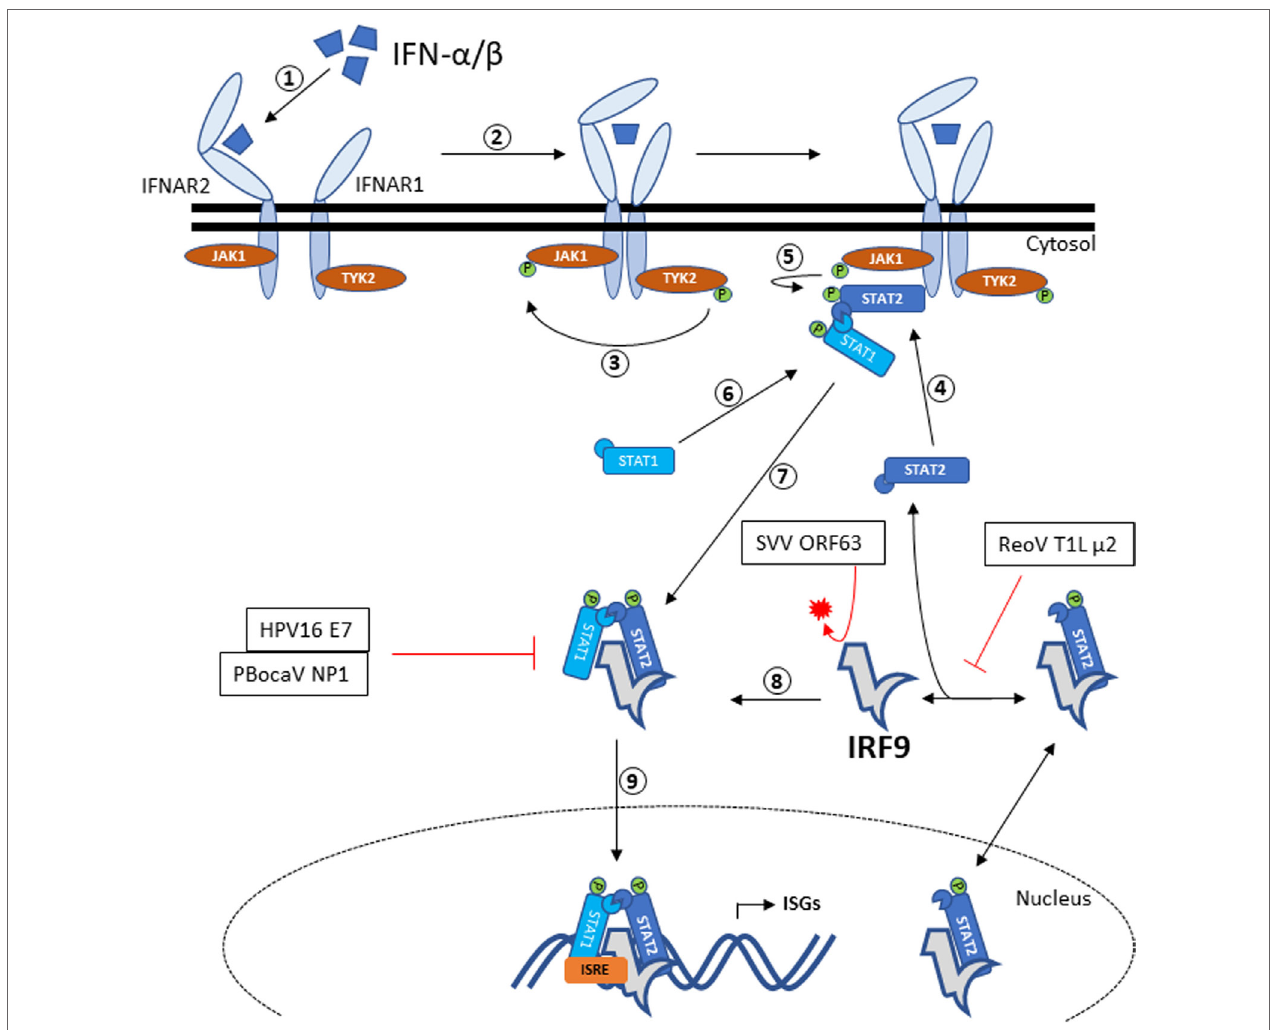
FiGURe 1 | IRF9 signaling via the JAK–STAT pathway and antagonism by viral proteins. Recognition of IFN- α / β by IFNAR2 will trigger heterodimerization to IFNAR1, resulting in autophosphorylation of TYK2. Activated TYK2 then phosphorylates the adjacent JAK1. STAT2 recruited by activated IFNAR2 will be phosphorylated by JAK1, thus allowing docking of STAT1 that in turn gets phosphorylated. The phosphorylated STAT1–STAT2 heterodimer then dissociates from the IFNARs and forms the ISGF3 complex with IRF9. ISGF3 complex is then translocated into the nucleus and bind to the ISRE promoter sequence to initiate the transcription of ISGs. IRF9 has been shown to associate with STAT2 and shuttles between the cytoplasm and nucleus. Also annotated are the viral antagonisms directed toward IRF9. HPV16 E7, ReoV T1L μ 2, and PBocaV NP1 binds to IRF9 and therefore prevents the formation of ISGF3 complex. Meanwhile, SVV ORF63 directs the proteasomal degradation of IRF9. Abbreviations: HPV16 E7, human papillomavirus 16 E7; SVV ORF63, simian varicella virus ORF63; ReoV T1L μ 2, reovirus T1L μ 2; PBocaV NP1, porcine bocavirus NP1; IRF9, interferon regulatory factor 9; IFNAR, IFN alpha receptor; TYK2, tyrosine kinase 2; JAK-STAT, Janus kinase–signal transducer and activator of transcription; ISGF3, interferon-stimulated gene factor 3; ISGs, interferon-stimulated genes; ISRE, interferon-stimulated response